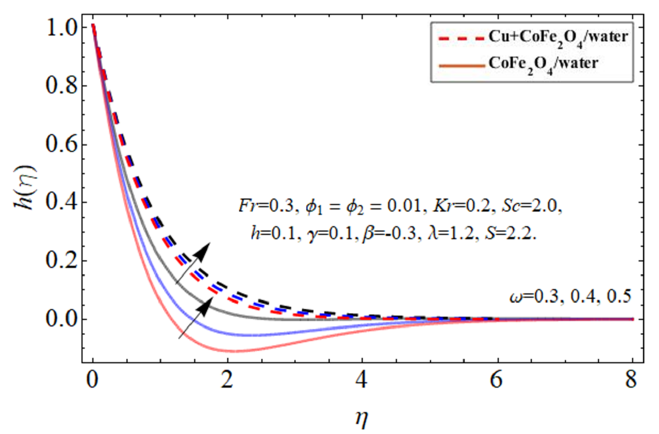
( ) h η against disk term . ω